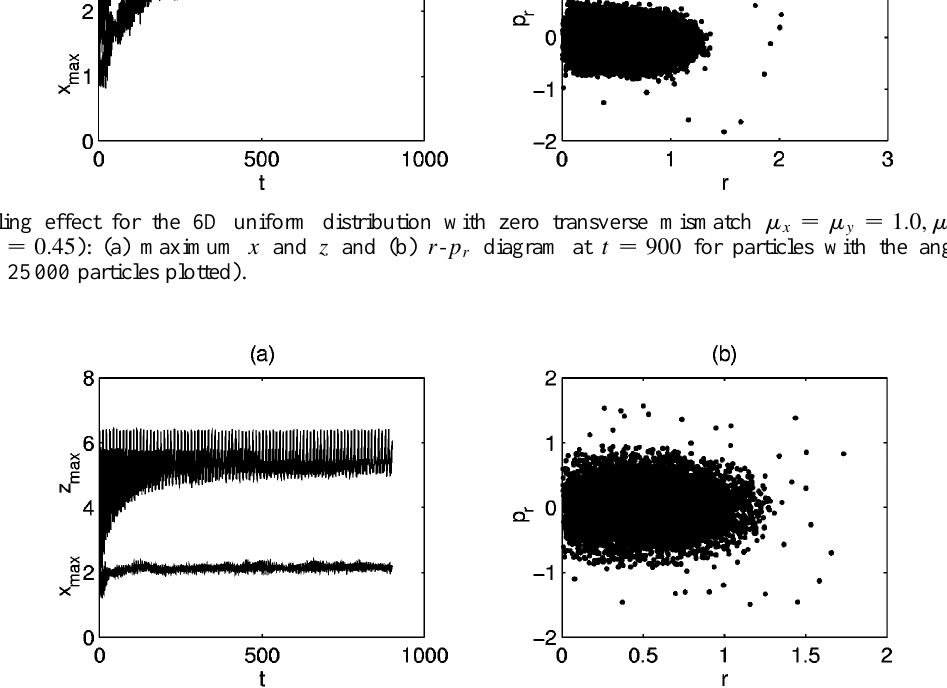
FIG. 19. Coupling effect for the 6D Gaussian distribution with zero transverse mismatch m (cid:120) (cid:173) m (cid:121) (cid:173) (cid:49)(cid:46)(cid:48)(cid:44) m (cid:122) (cid:173) (cid:49)(cid:46)(cid:53) ( (cid:99) (cid:121) (cid:97) (cid:173) (cid:50)(cid:44) h (cid:120) (cid:173) (cid:48)(cid:46)(cid:53)(cid:53)(cid:44) h (cid:122) (cid:173) (cid:48)(cid:46)(cid:52)(cid:53) ): (a) maximum (cid:120) and (cid:122) and (b) (cid:114) (cid:45) (cid:112) (cid:114) diagram at (cid:116) (cid:173) (cid:57)(cid:48)(cid:48) for particles with the angular momentum j (cid:76) j , (cid:48)(cid:46)(cid:49) (with 25000 particles (cid:122)